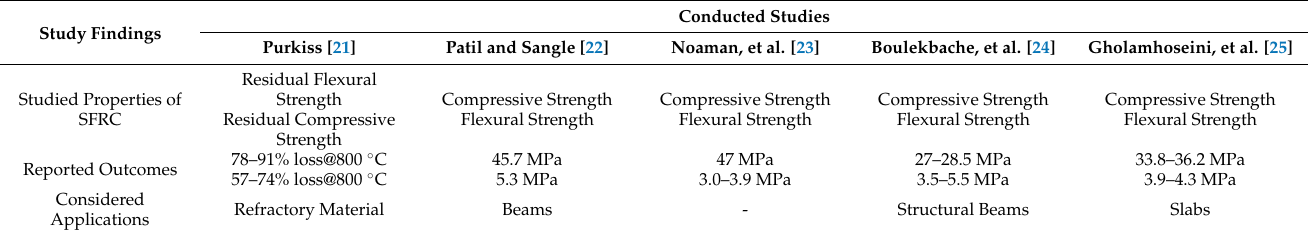
Table 1. Reported applications and properties of SFRC.